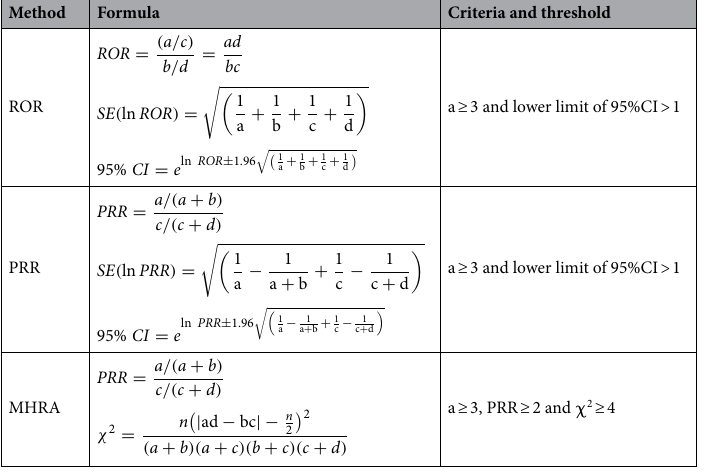
Table 2. Formulas and criteria for generating signals of ROR, PRR and MHRA.